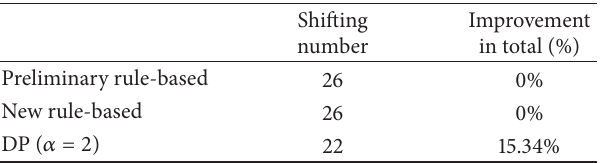
Table 3: Comparison of different control strategy in shifting